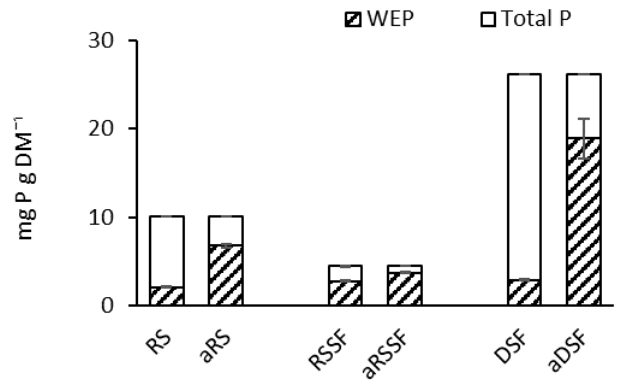
Figure 2. Water extractable phosphorus (WEP) in non-acidified organic products: Raw dairy slurry (RS), raw dairy slurry solid fraction (RSSF) and digestate solid fraction (DSF), and in acidified organic products: acidified dairy slurry (aRS), acidified dairy slurry solid fraction (aRSSF) and acidified digestate solid fraction (aDSF).